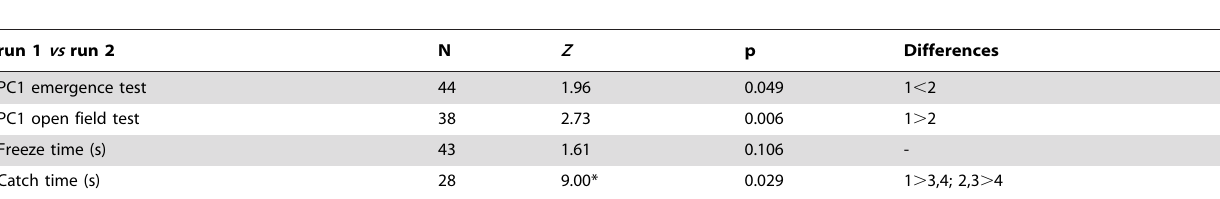
Table 5. Wilcoxon pair-wise comparisons* testing for behaviour differences between repeated runs of four behaviour assays, data pooled for mid-season and late